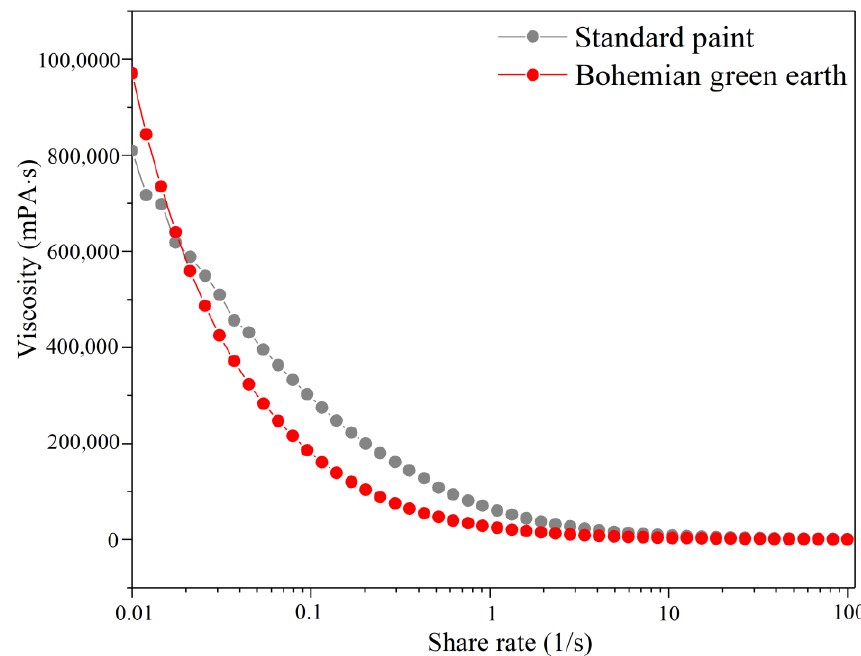
Figure 6. Viscosity curves for the standard paint formulation and paint with bohemian green earth. As can be seen in Figure 6, the modified paint presents higher initial viscosity com- pared to the standard formulation, although it liquefies more easily at low shear-rate values (0.01–1), suggesting it might present less viscous behavior during storage. At mid-shear rates (1–10), the paints show similar viscosity, meaning they would present similar behav- ior while mixing in the can. However, the steeper slope in the case of the modified paint might indicate a higher tendency for sagging. Finally, in the application range (10–100) the viscosity of the samples is indistinguishable as the graphs are